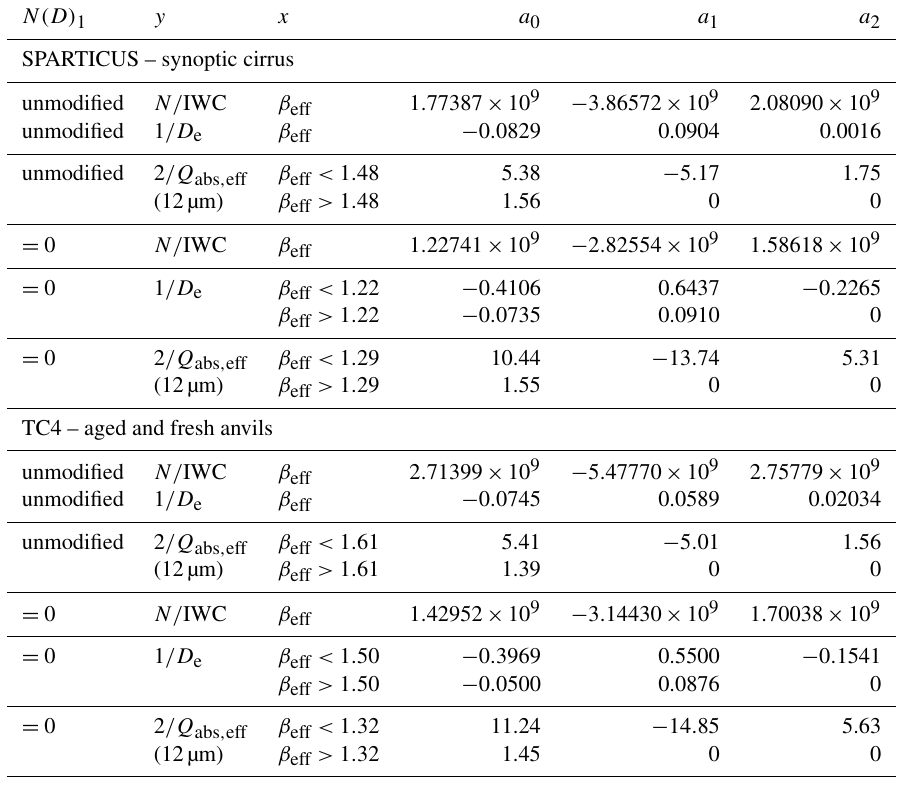
Table 1. Regression curve variables and coefficients for second-order polynomials of the form y = a 0 + a 1 x + a 2 x 2 , used in the CALIPSO retrieval. Units for N/ IWC and D e are in g − 1 and microns,